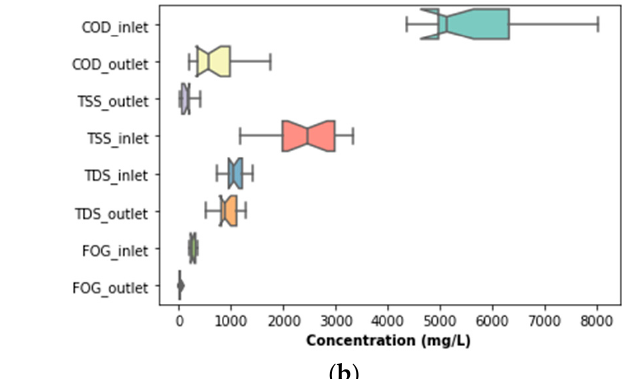
Figure 14. Performance of PSW DEGBR after outliers’ detection and replacement. The performance of the DEGBR was further assessed for relatedness, as shown in Figures 15–17, which showed the response of the DEGBR in terms of the removal of the FOG, COD, and TSS, respectively, when a variation of the OLR was implemented in the experiment. A comparison of these graphs shows a better response of the DEGBR for the removal of COD, despite the various fluctuations of the OLR varying from ~18 to ~45 gCOD/L.d. Despite a good consistency in the evolution of the COD removal efficiencies, the DEGBR performance was higher at the beginning of the process for both the TSS and FOG removal efficiencies, as displayed in Figures 16 and 17, with ranges varying between ~84 and ~98% for the TSS removal, and ~85% and ~93% for the FOG removal, which is an indication that the AD bed acted as a bio-filter, perhaps with some hydrolysis capacity.